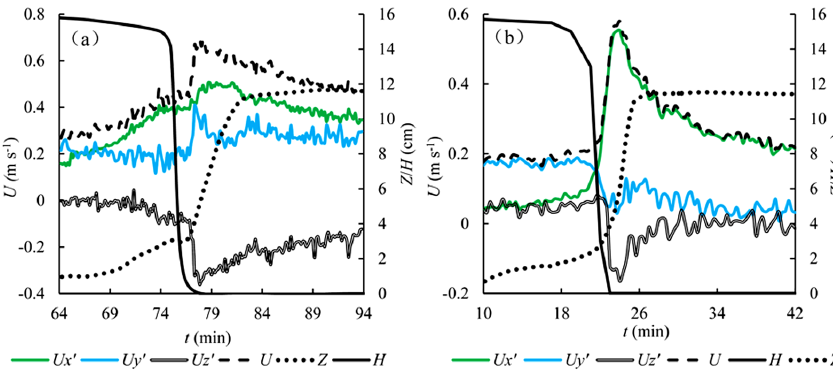
Figure 12. Relation between water level, velocity and breach height: (a) case C-1, (b) case C-2.